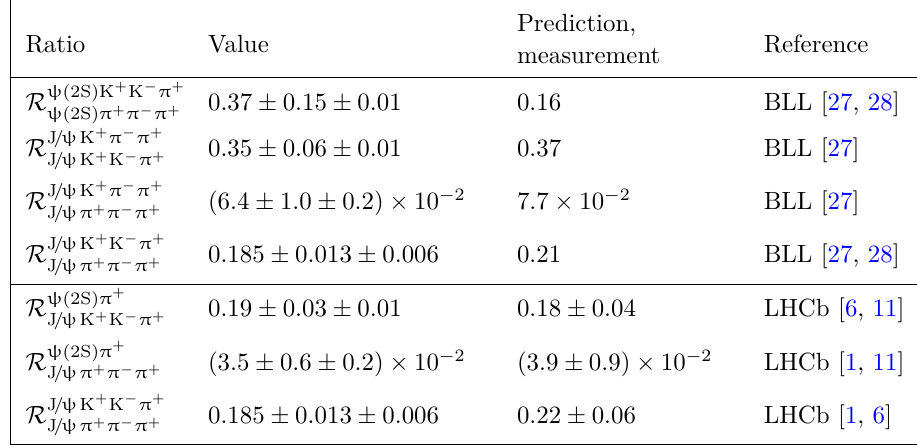
with their theoretical predictions or derivations Y